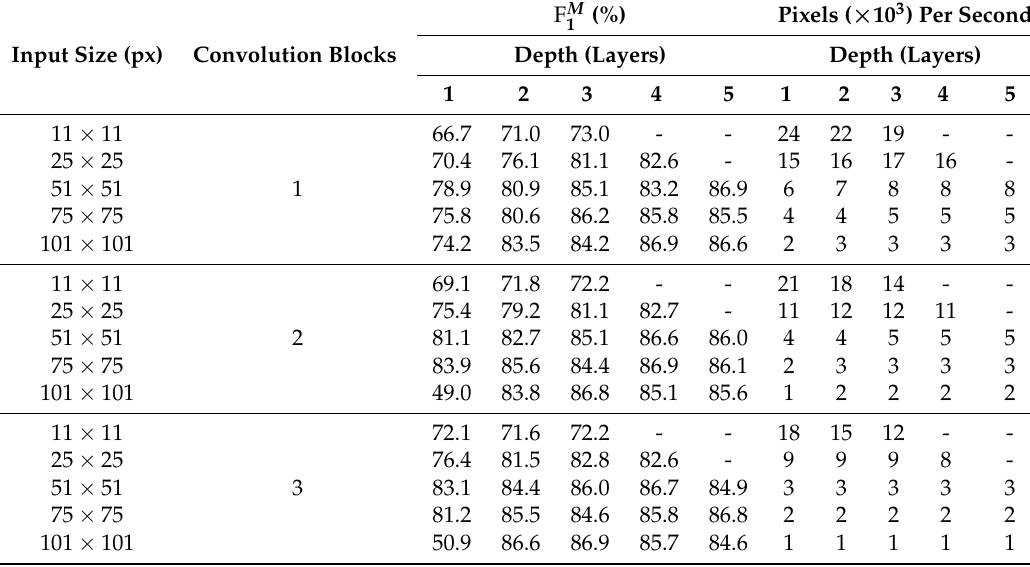
Table 3. Results in terms of F M and pixels per second of the different configurations. All CNN 1 are configured to 32 filters per convolution, 3 × 3 kernels and trained with 20,000 random samples per class—being a total of 100,000 prototypes. Results reported represent averages from a five-fold cross-validation scheme over Einsiedeln